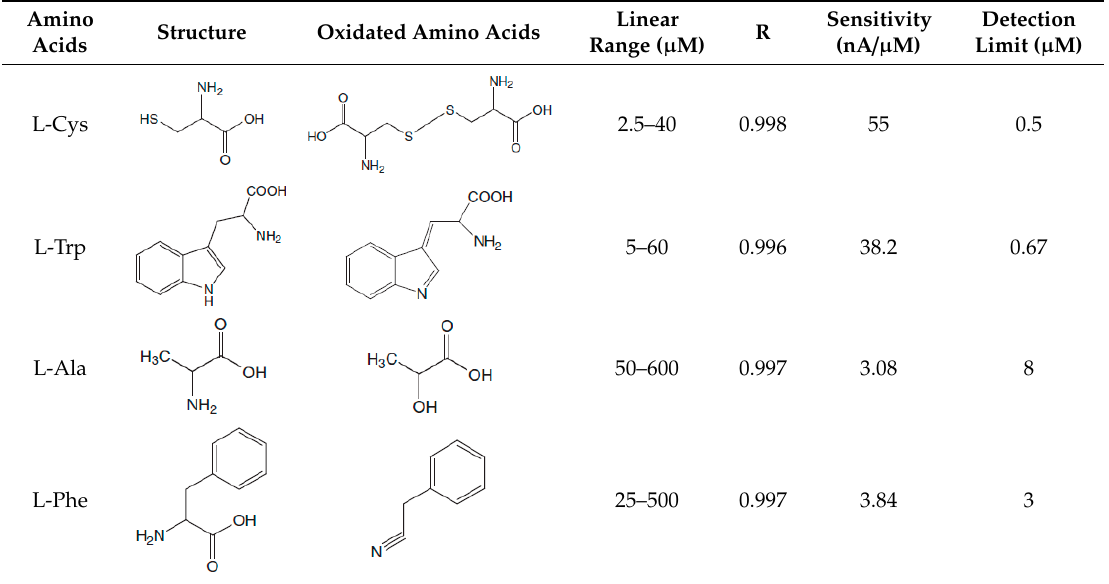
Table 1. The analytical characteristics of the sensor regarding the detection of amino acids: L ‐ Cys, L ‐ Trp, L ‐ Ala and L ‐ Phe. Reprinted from [63] with permission of publisher. Amino Acids Structure Oxidated Amino Acids